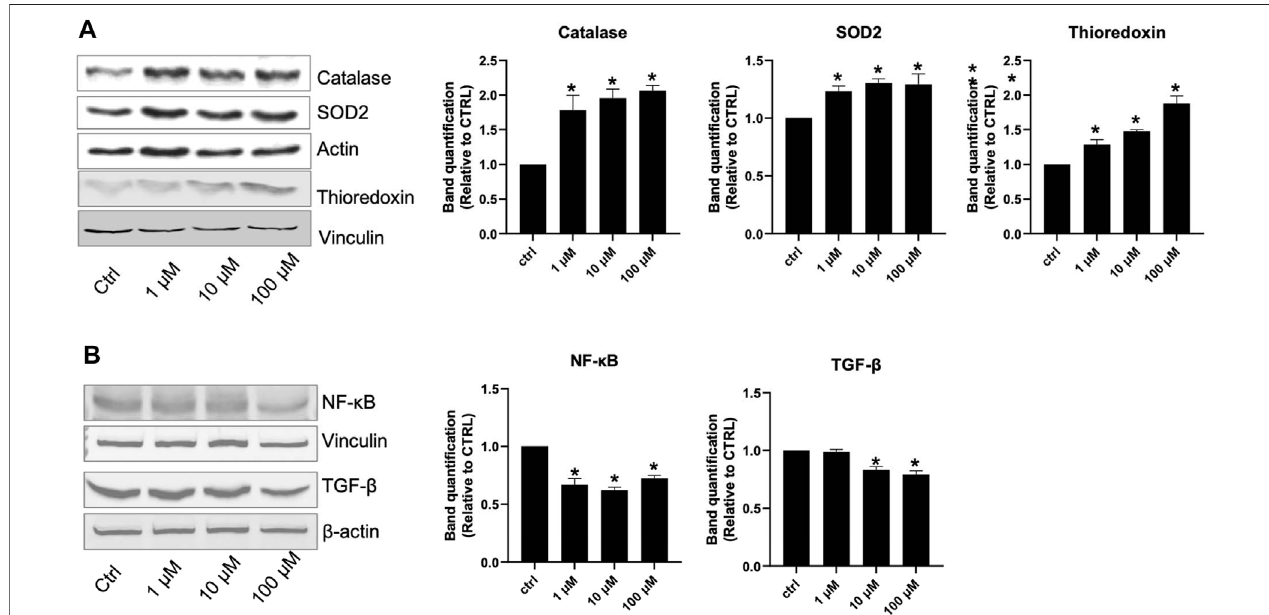
FIGURE 1 | Effects of lisinopril treatment on proteins involved in oxidative stress defense and the in fl ammatory response. (A,B) Western blot analysis of proteins involved in oxidative stress response and in fl ammation. Data are mean ± standard errors. * p < 0.05 vs. CTRL.